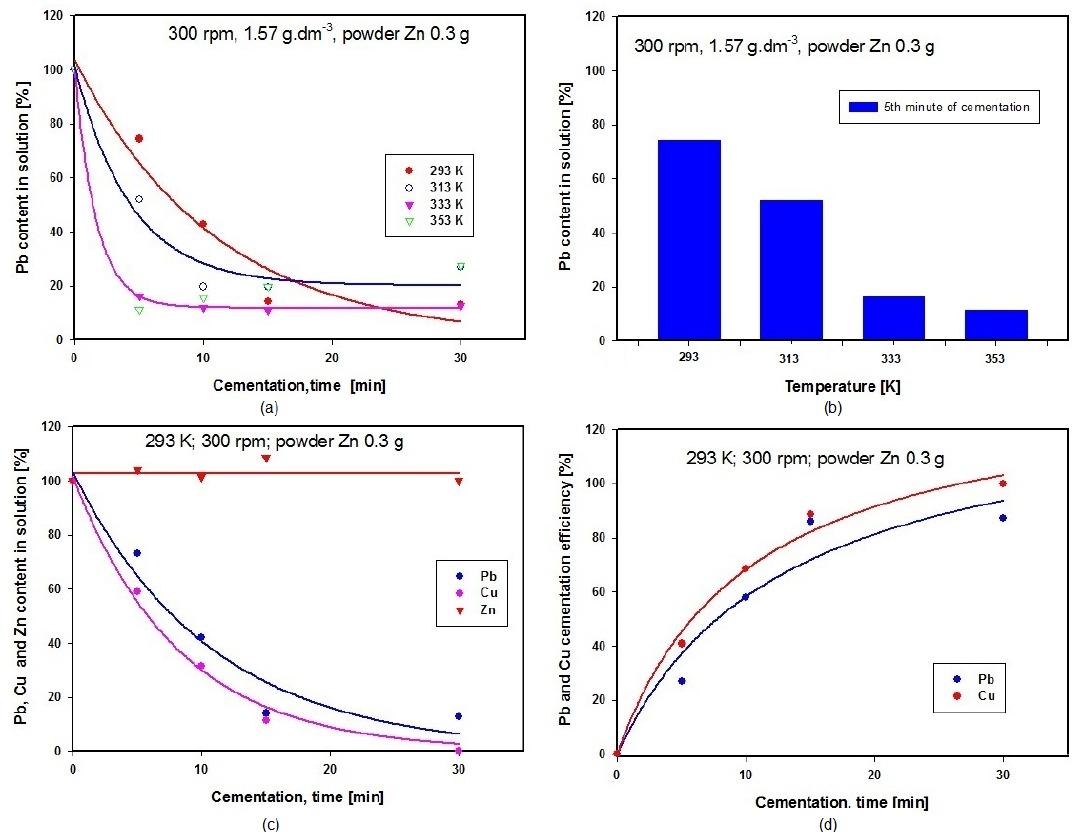
Figure 5. ( a ) Time dependence of Pb content in solution during cementation at different temperatures; ( b ) Comparison of Pb concentrations after 5 min cementation at different temperatures; ( c ) Time dependence of Pb, Cu and Zn concentrations in solution during cementation using zinc; ( d ) Comparison of Pb and Cu cementation efficiencies at 293 K.